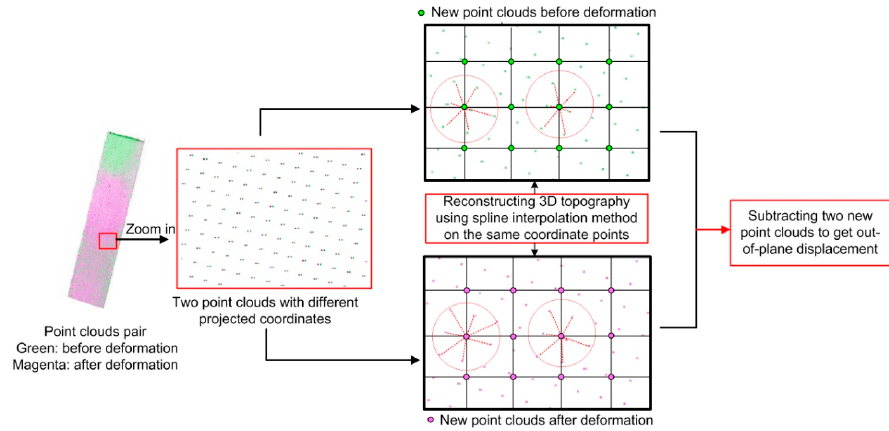
Figure 13. Displacement extraction algorithm based on 3D point clouds.